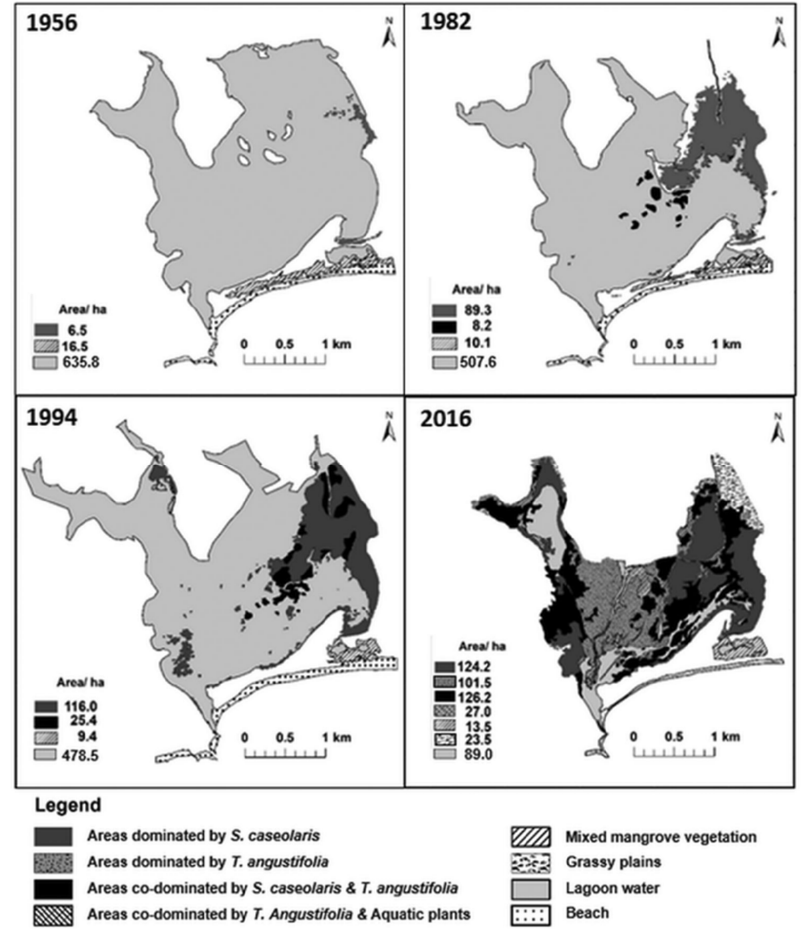
Figure 1. Maps of Kalametiya Lagoon showing spatio-temporal changes of vegetation over the last six decades (1956–2016). Eight considered habitat types are described in the legend, along with their respective patterns: (i) areas dominated by S. caseolaris (dark grey), (ii) areas dominated by T. angustifolia (grey with black spots), (iii) areas co-dominated by S. caseolaris and T. angustifolia (black), (iv) areas co-dominated by T. angustifolia and aquatic plants (white with two layers of black stripes), (v) mixed mangrove vegetation (white with one layer of black stripes), (vi) grassy plains (white with grass symbols), (vii) lagoon water (light grey), (viii) beach (white with black spots). When habitats are present in the map, corresponding area is added in ha on the side of the map. A scale in kilometres is presented under each map. Figure adopted from Madarasinghe et al. (2020) [11].